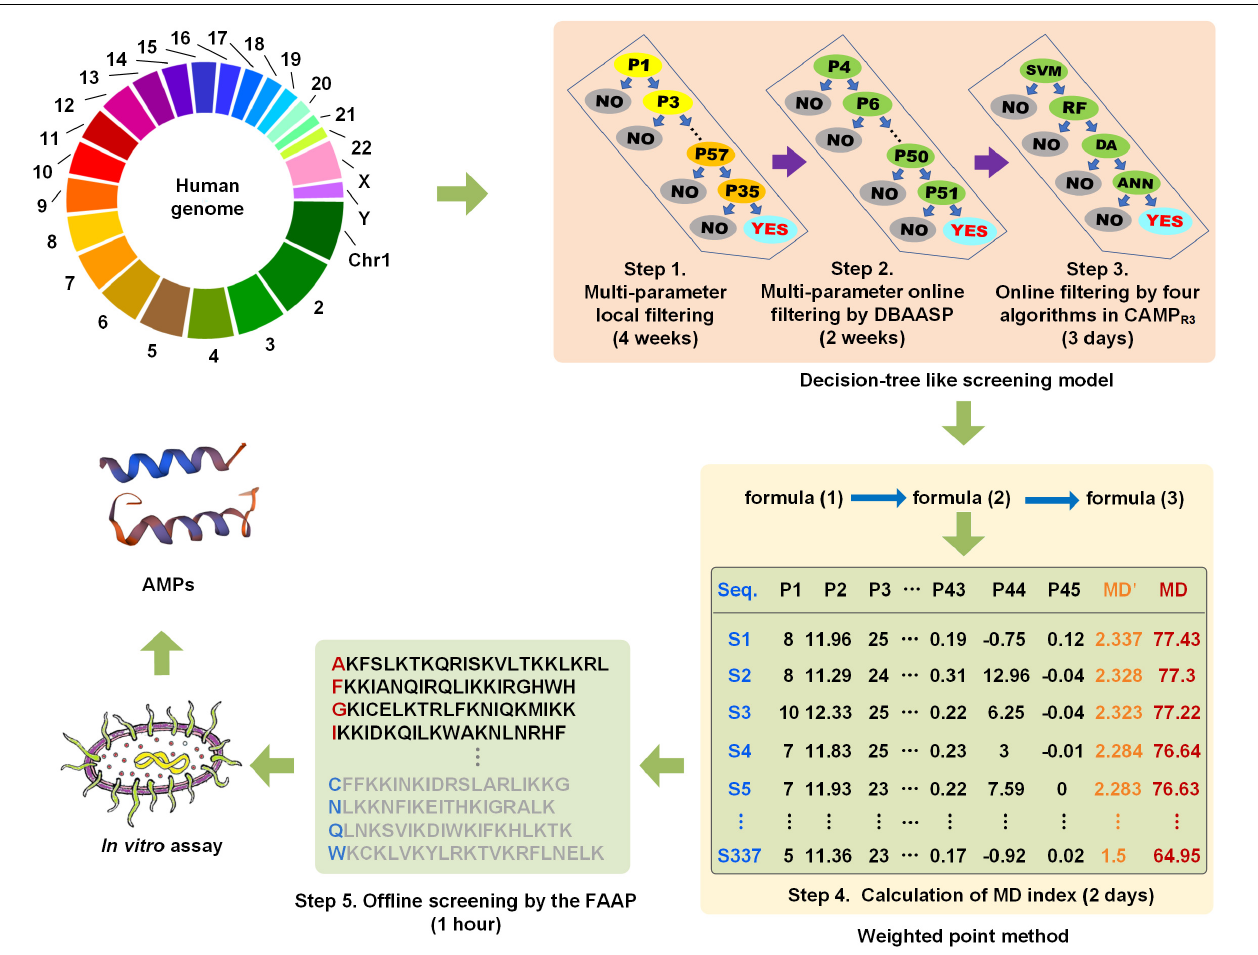
FIGURE 3 | The schematic diagram of the screening of cryptic α -helical antimicrobial peptides (AMPs) with the MultiDS